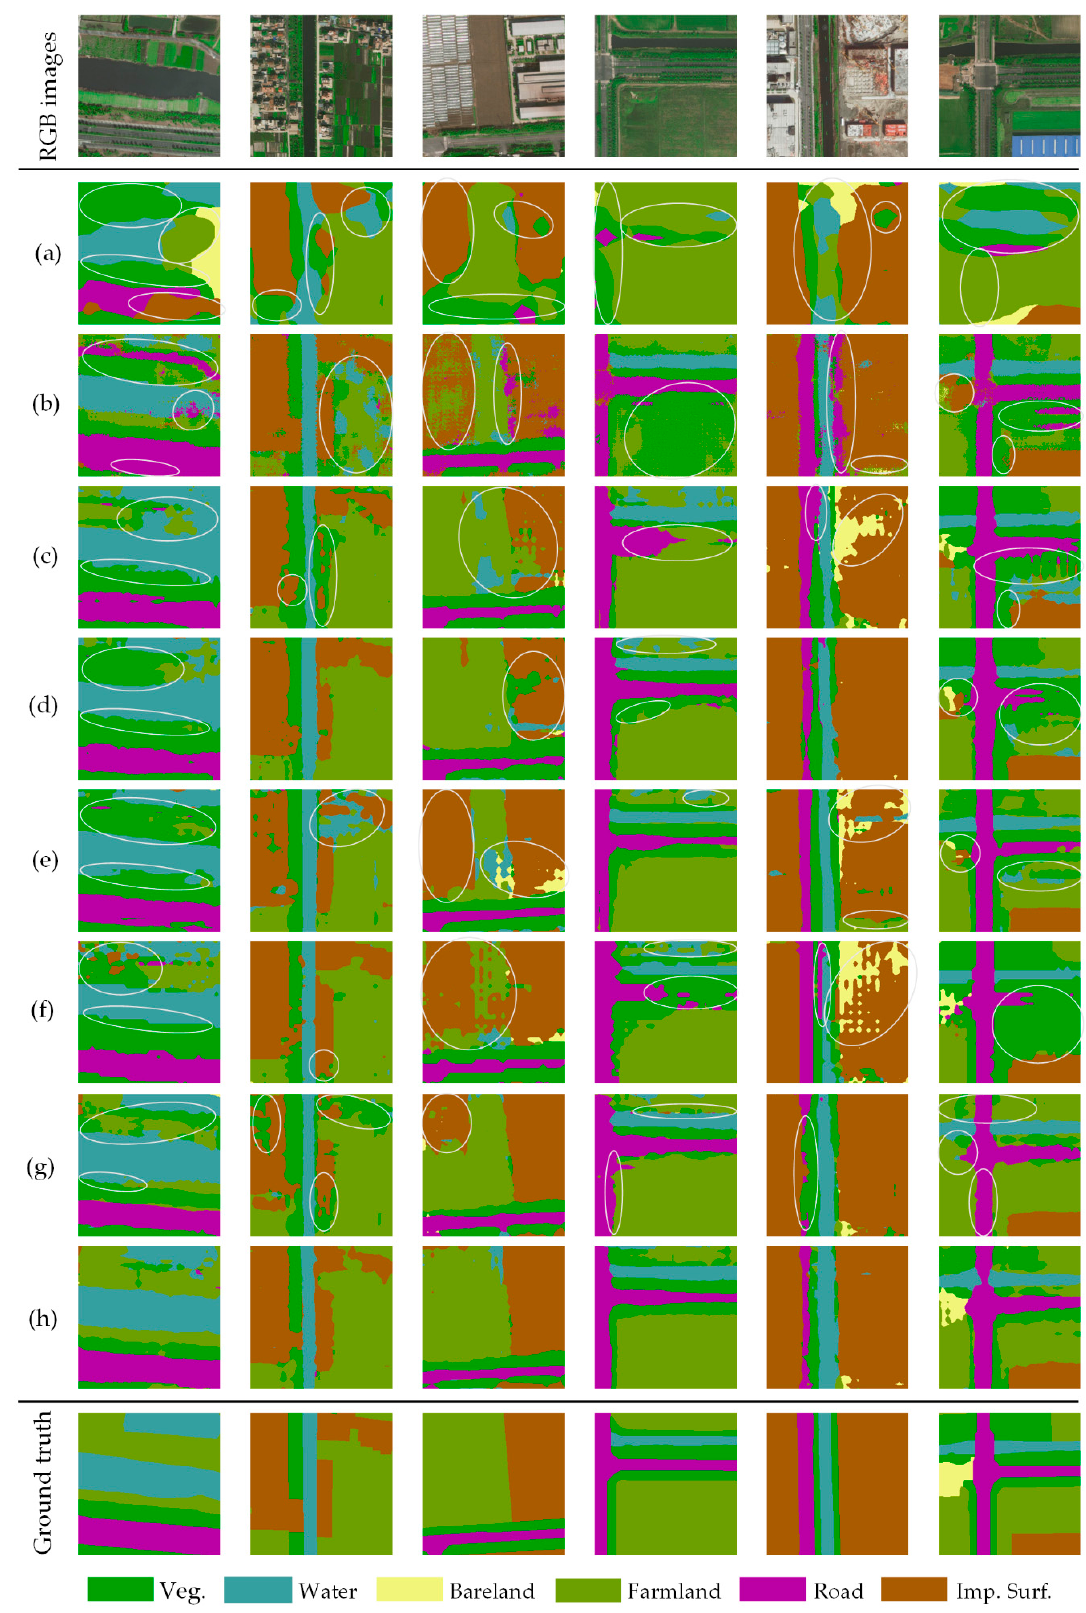
Figure 6. Representative examples of land cover mapping on the task Shanghai → Zhejiang: ( a ) FCNs ITW, ( b ) CyCADA, ( c ) AdaptSegNet, ( d ) CLAN, ( e ) ADVENT, ( f ) BDL, ( g ) FADA, ( h ) our CsCANet. RGB images and the corresponding ground truth are presented in unison. We circle the negative results in white ellipses.